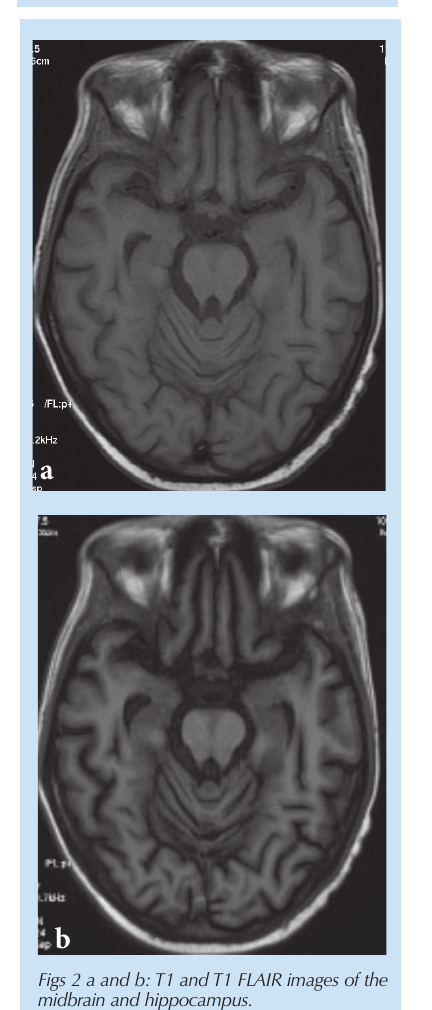
b Figs 2 a and b: T1 and T1 FLAIR images of the midbrain and hippocampus.